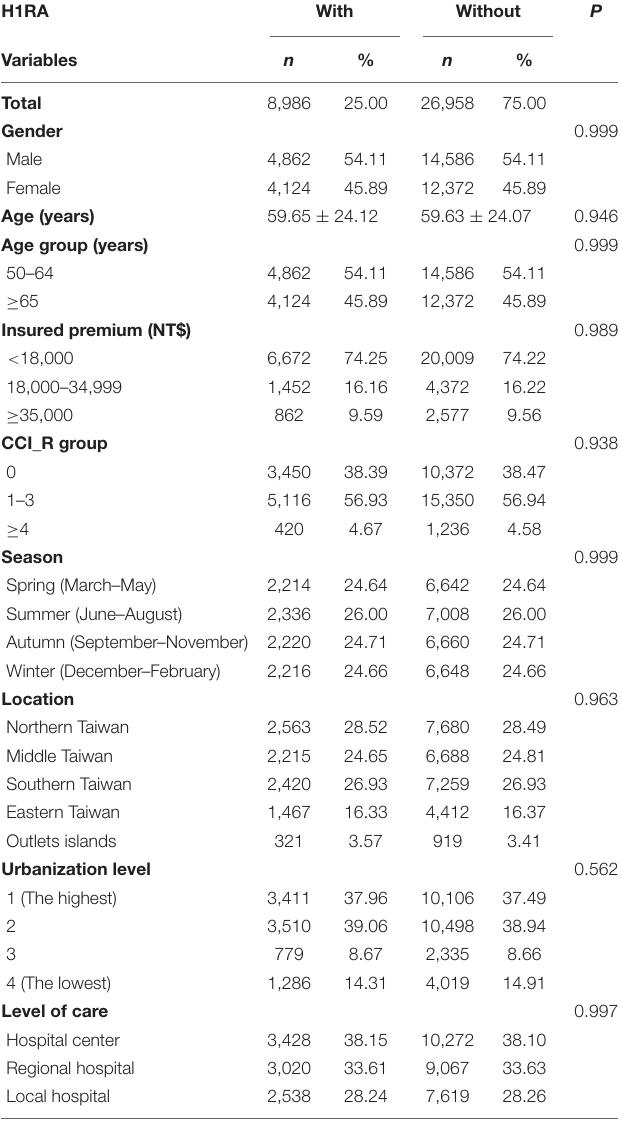
TABLE 1 | Characteristics of study in the